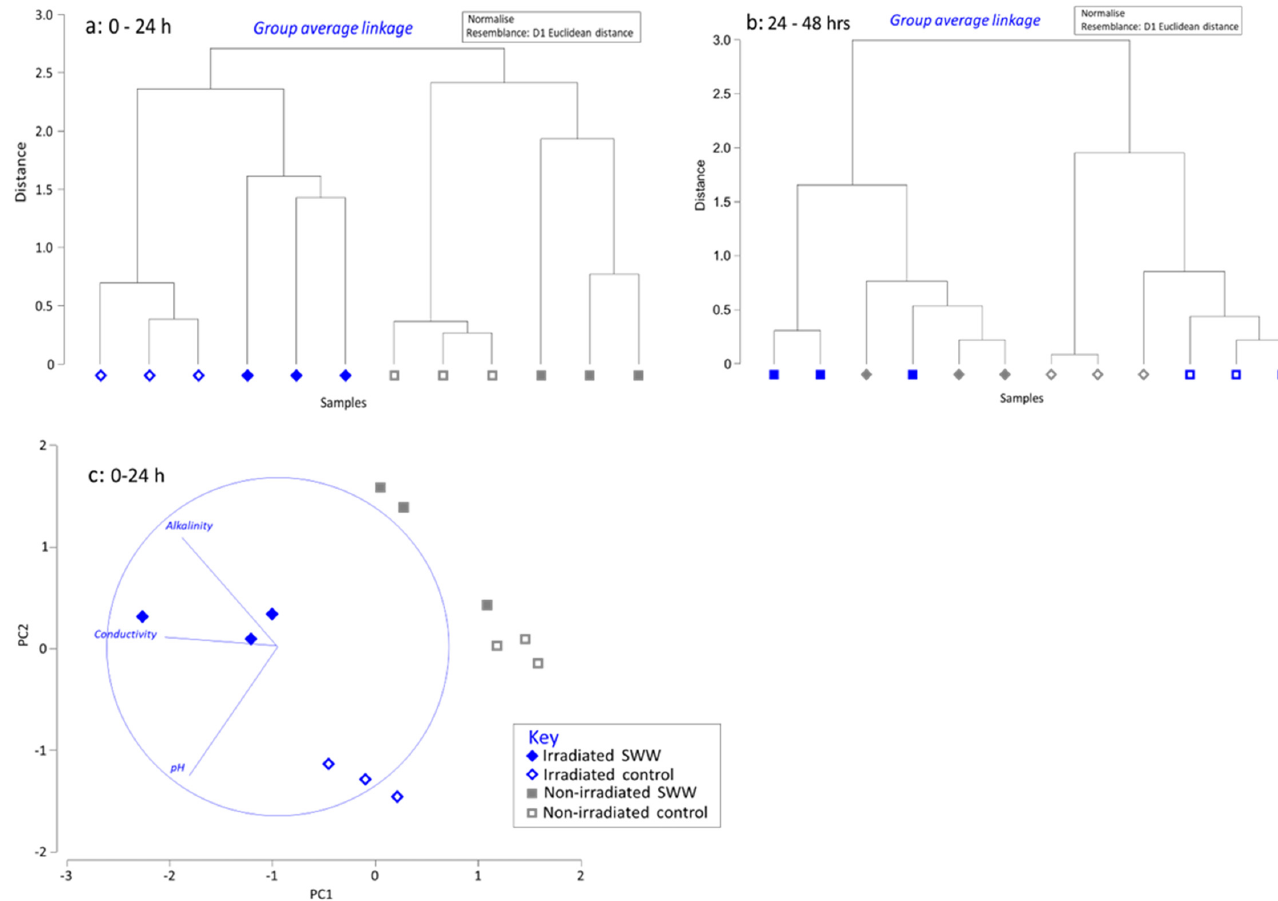
Figure 6. Cluster plots of selected physicochemical parameters showing the different treatment groups in eluant samples taken between 0–24 h ( a ) and 24–48 h ( b ), and principal component analyses of the same data from eluant samples taken between 0–24 h ( c ).